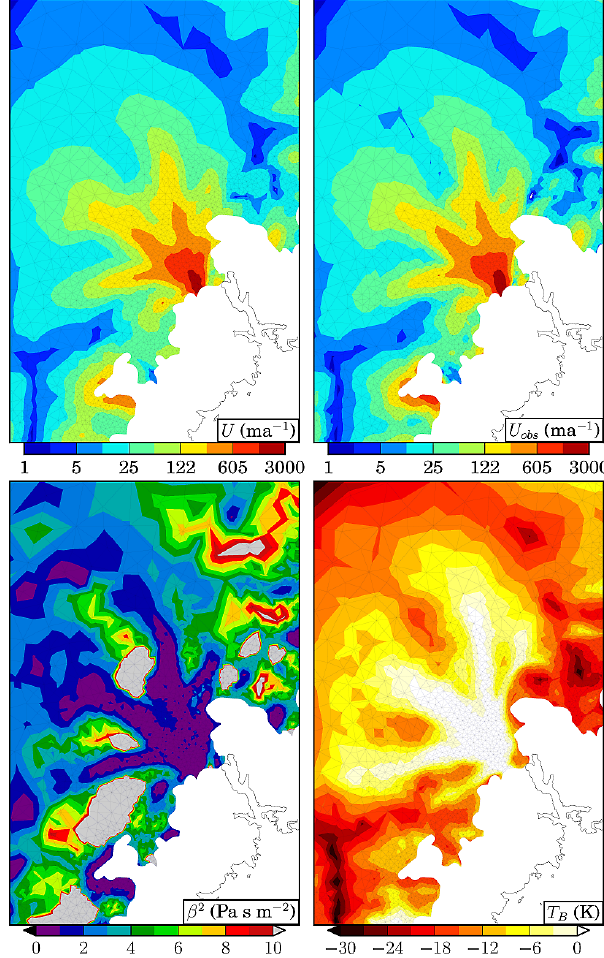
Fig. 12. Modelled and measured surface velocities, basal traction, and basal temperature of the GIS after assimilation of surface ve- locity. RMS velocity mismatch is 36ma − 1.